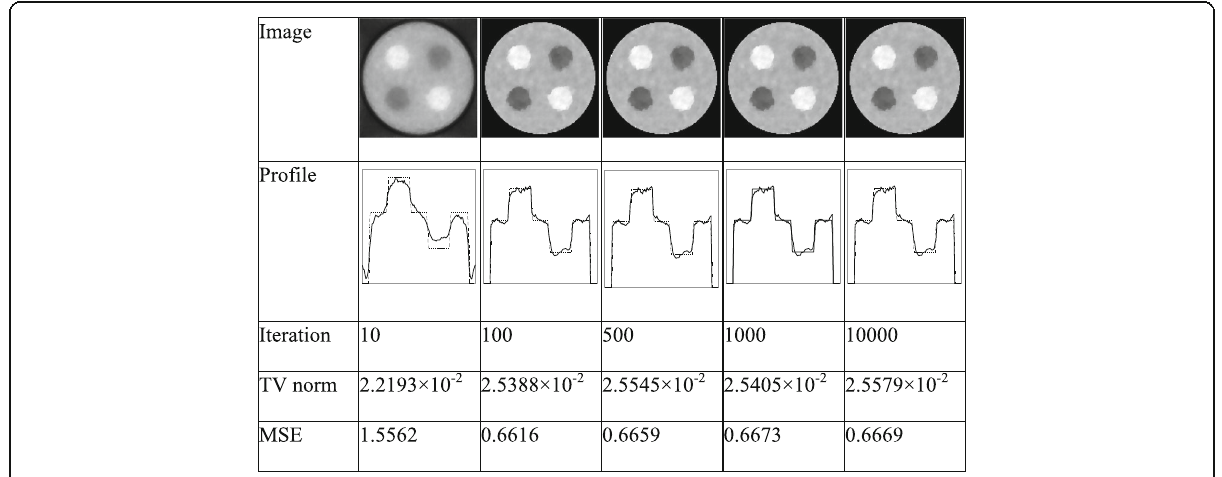
Fig. 4 Reconstructions of emission data using the proposed algorithm with β =